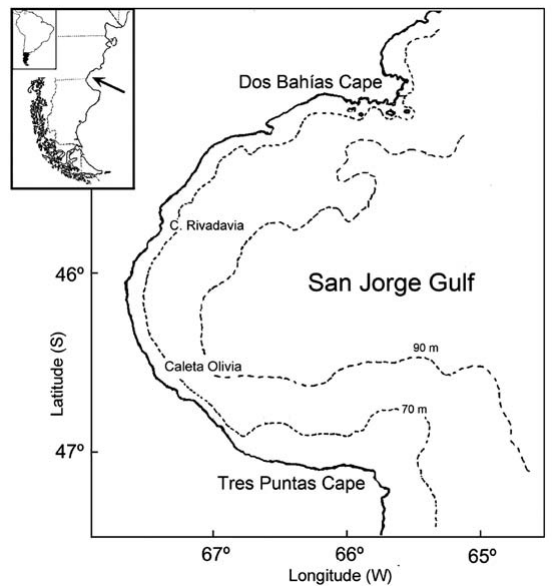
Fig. 1. – San Jorge Gulf, southwestern Atlantic